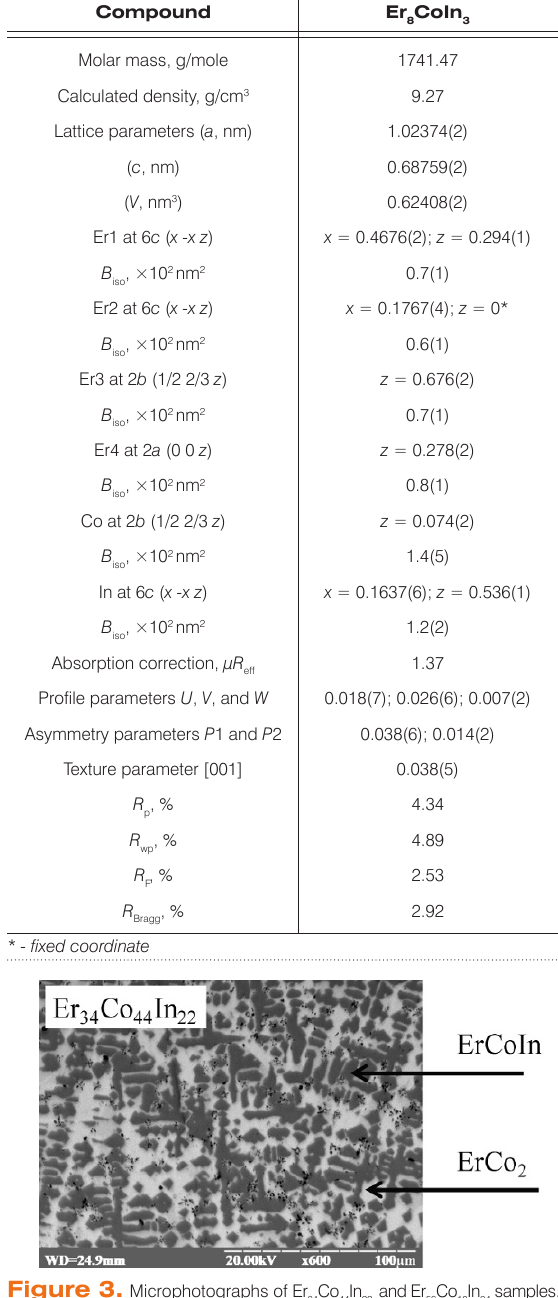
Table 2. Results of structure refinements for Er